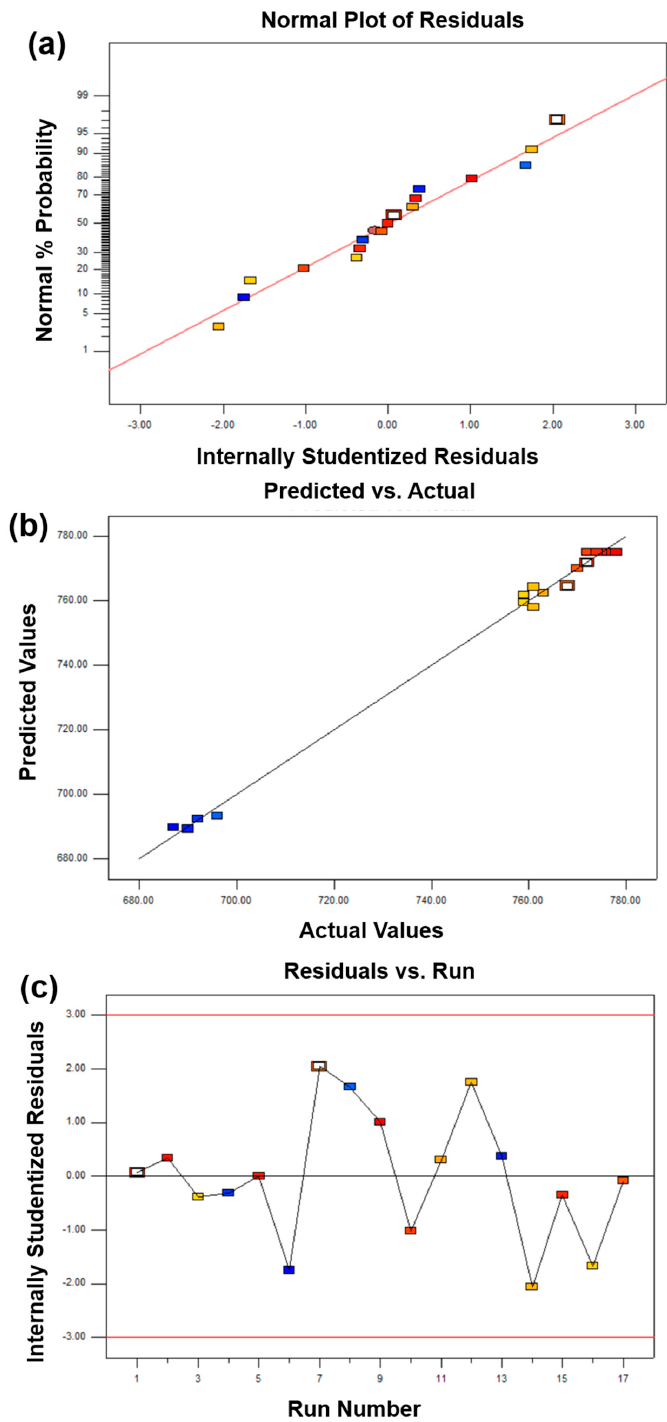
Figure 3. The adequacy of diagnostic maps of the flexural strength BBD model: ( a ) comparison of normal probability with internal studentized residuals, ( b ) comparison between actual and predicted values, and ( c ) internally studentized of each experimental point.